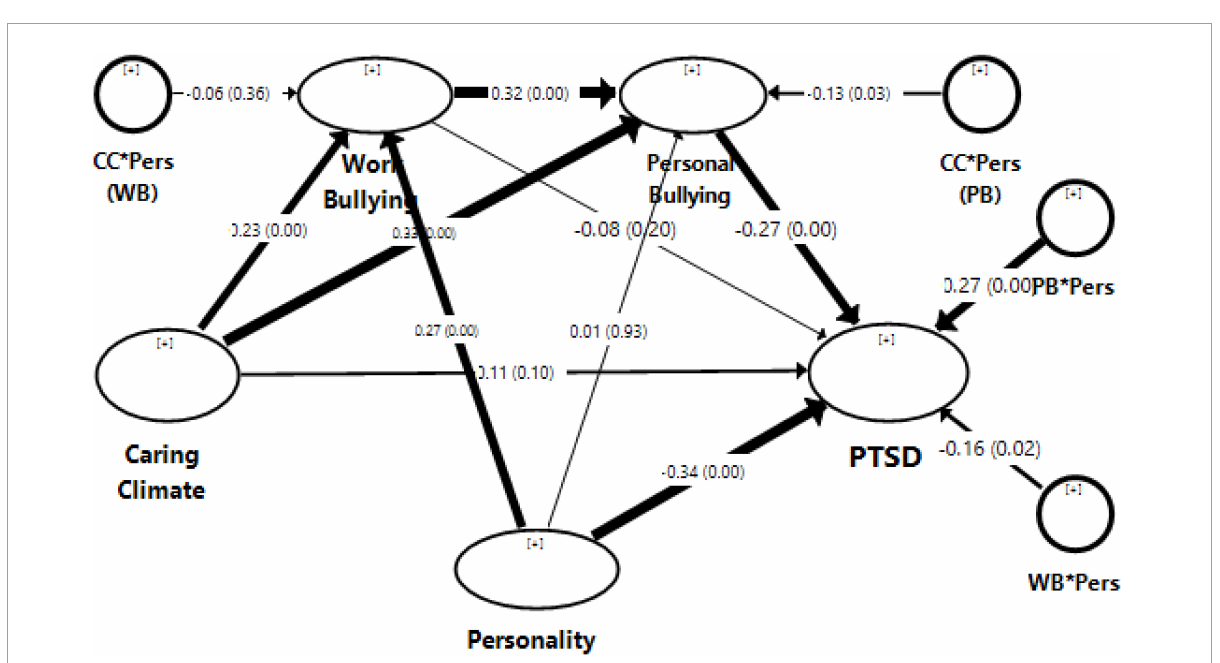
FIGURE2 Structural model. The above figure is a structural model exported from SmartPLS. In the figure, circles represent the moderating variables. The strength of the arrows shows the relative importance of the relationships. Path coefficients along with significance in parentheses are also provided at each